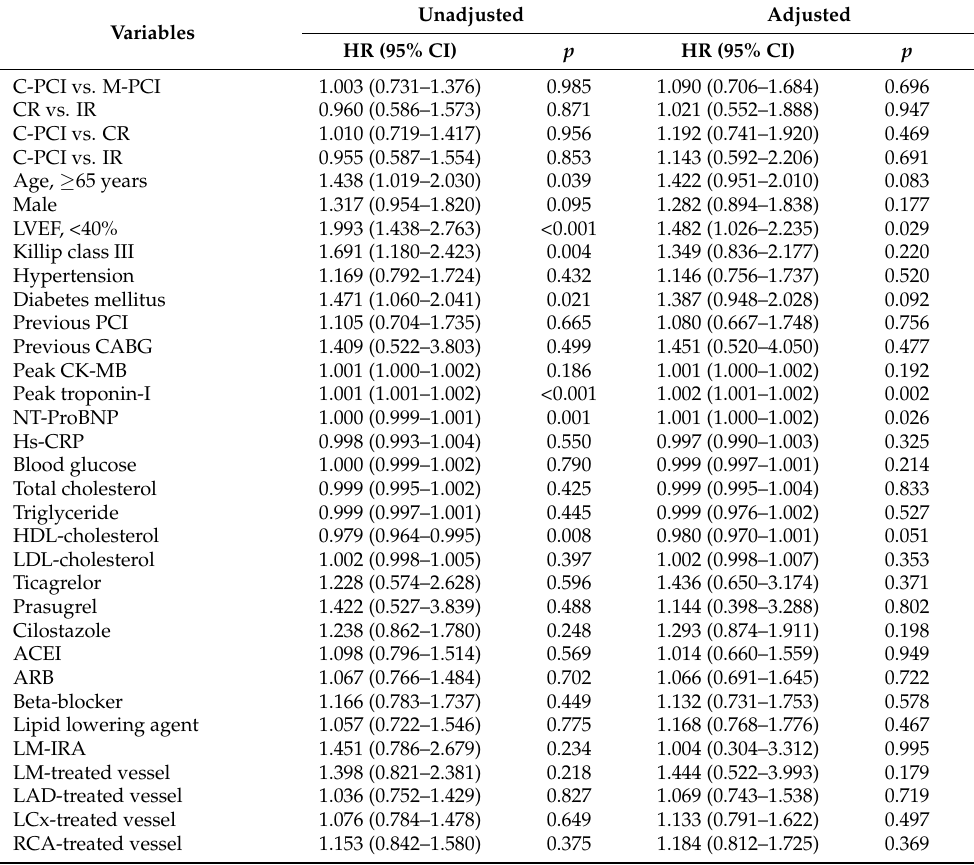
Figure 2. Kaplan-Meier analyses for the MACE ( A ), all-cause death ( B ), cardiac death ( C ), recurrent MI ( D ), any repeat revascularization ( E ), TVR ( F ), non-TVR ( G ) and ST ( H ) between the C-PCI group and the M-PCI group and the CR group and the IR group at 2 years. aHR, adjusted hazard ratio; CI, confidence interval; MACE, major adverse cardiac events; MI, myocardial infarction; TVR, target vessel revascularization; C-PCI, culprit-only PCI; M-PCI, multivessel PCI; CR, complete revascularization; IR, incomplete revascularization. Table 3. Independent predictors for MACE.